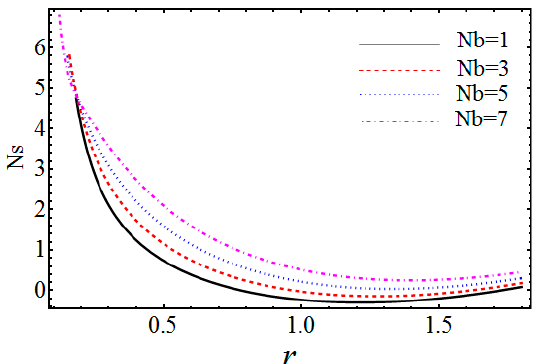
Figure 13. Curves of 𝑁𝑠 with fixed 𝐺𝑐 where 𝜃 = 0.1, 𝜑 = 0.5, 𝛿 = 0.01,𝜀 = 0.01,𝑉 = 0.3, 𝜆 (cid:2869) = 1, 𝑧 = 0,𝑡 = 0.1,Γ = 0.4, 𝑁𝑏 = 0.9, 𝑁𝑡 = 0.5,𝐵𝑟 = 1, 𝐺𝑟 = 3, Λ = 0.4, Ω = 0.3, 𝑄 = 1.